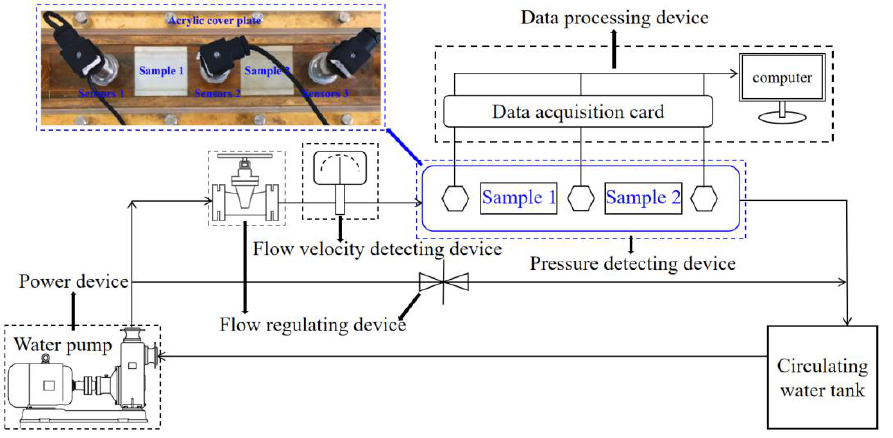
Figure 3. Flow channel.